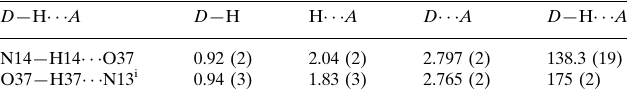
Hydrogen-bond geometry (A˚ , (cid:1) ). D —H (cid:2)(cid:2)(cid:2) A D —H H (cid:2)(cid:2)(cid:2) A D (cid:2)(cid:2)(cid:2) A D —H (cid:2)(cid:2)(cid:2) A